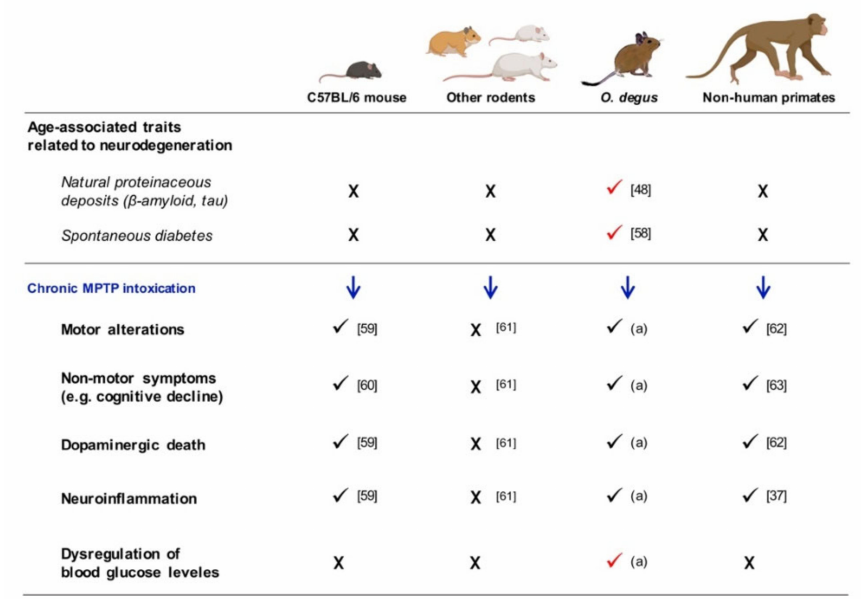
Figure 8. Summary of the effects of the chronic MPTP intoxication in different experimental models. “X” symbol indicates that the feature has not been found in the experimental model, while the check symbol means the presence of the feature. [19] Inestrosa et al., 2005; [20] Spear and Caple, 1984; [21] Luchtman et al., 2009; [22] Deguil et al., 2010; [23] Riachi et al., 1989. (a) Demonstrated in the present study; [24] P é rez-Otaño et al., 1994; [25] Vezoli et al., 2004.; [26] Barcia et al.,